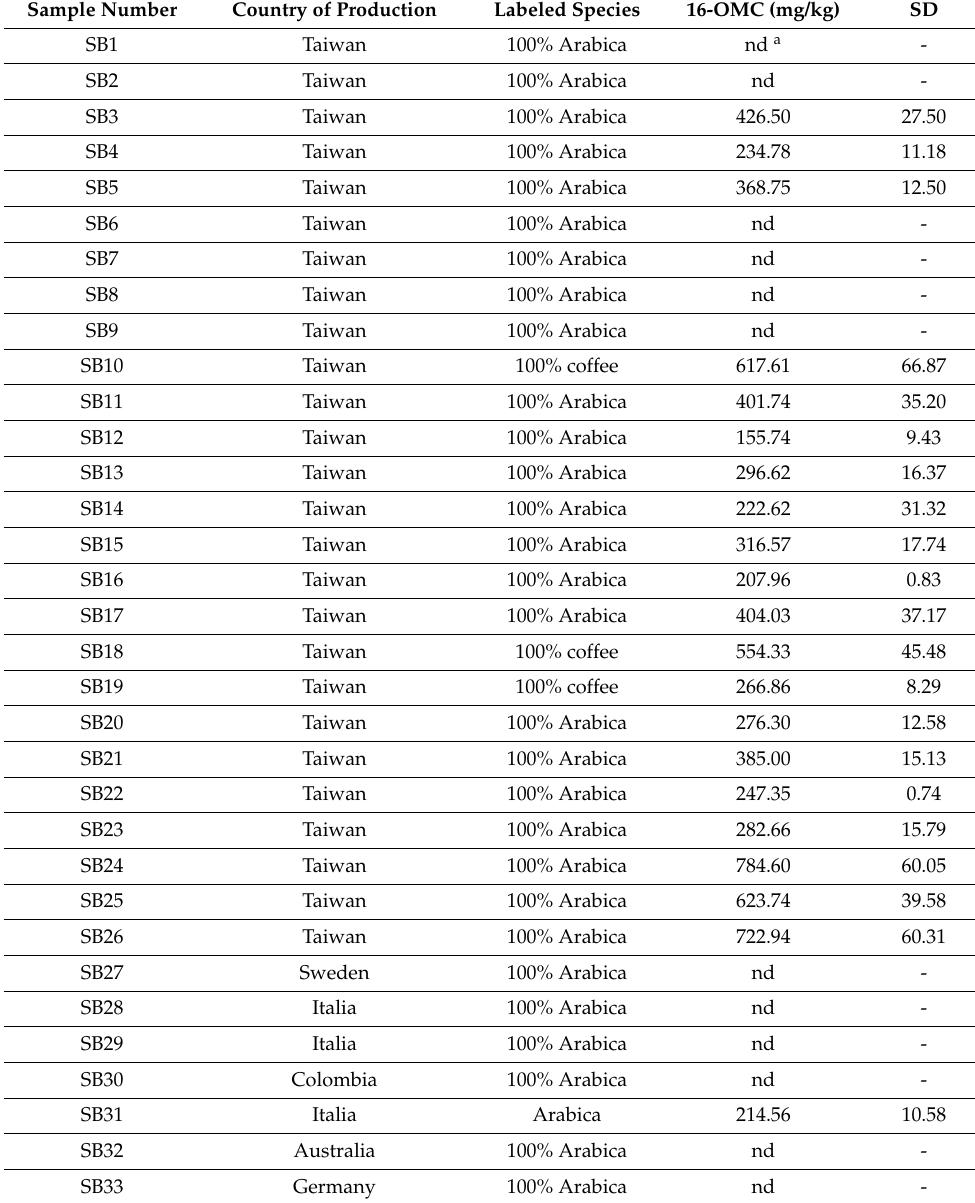
Table 1. Information and 16-OMC content of blend roast coffee